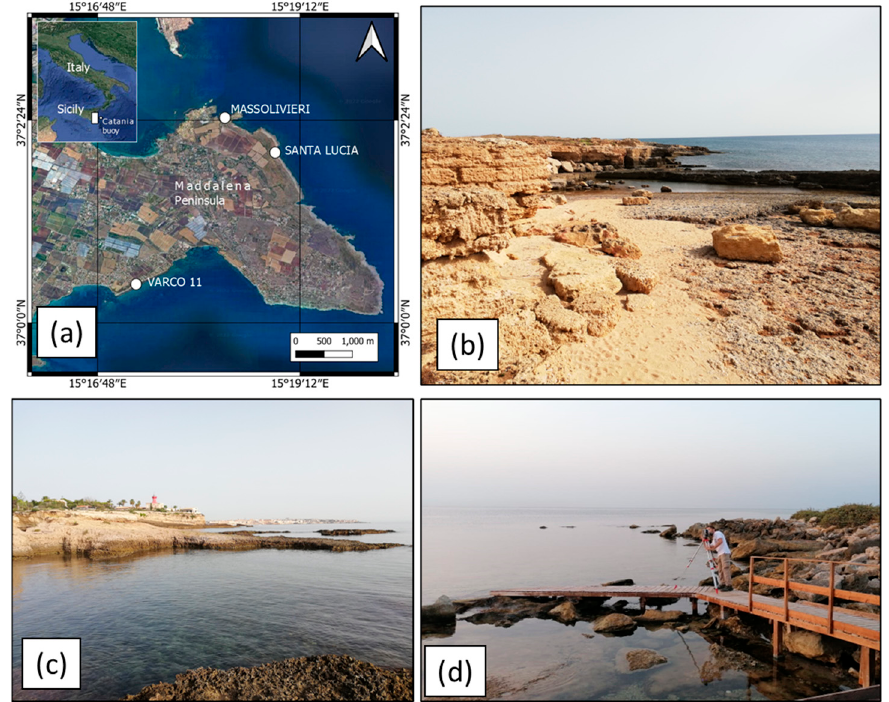
Figure 1. Rocky coastal areas on Maddalena Peninsula monitored by webcams set up on the Marine Protected Area (MPA) of Plemmirio (Siracusa, south-eastern Sicily); ( a ) locations of study areas in the Ionian Sea; ( b ) Greek quarry of Santa Lucia; ( c ) rocky coast of Massolivieri; ( d ) rocky coast of Varco 11.